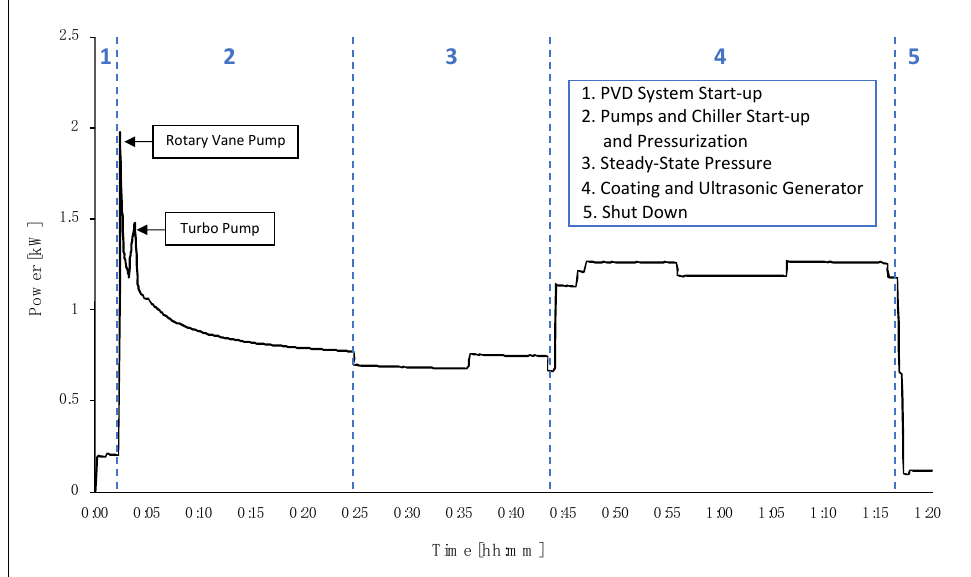
Figure 4. Power Consumption of the Magnetron Sputtering Physical Vapor Deposition Process (data measured at 2-s intervals; graph displays data at the same interval).